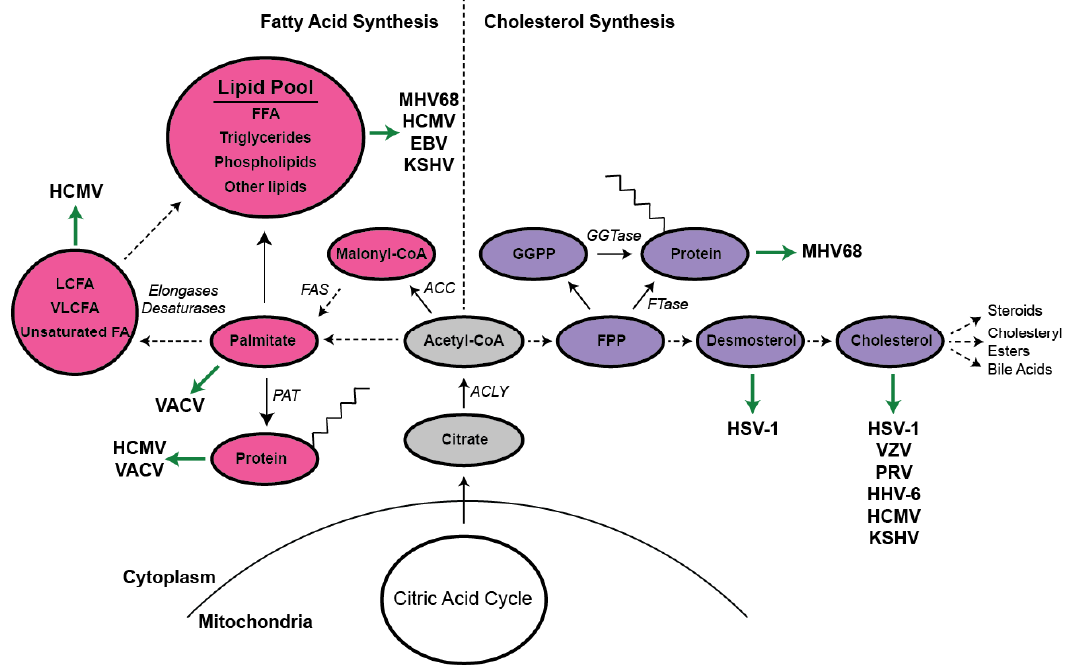
Figure 1. Summary of the interplay between DNA virus infection and cellular lipid metabolism. This model illustrates a number of enzymes and intermediates involved in the synthesis of cholesterol (purple, right side), fatty acids (pink, left side), and related compounds. The precursor acetyl-CoA feeds both the mevalonate and fatty acid synthesis pathways. Virus interactions with these compounds are indicated by green arrows. Solid black arrows indicate the direct conversion of one molecule to the next, whereas dashed arrows indicate additional steps that, for the sake of simplicity, are not depicted. To conserve space, prenyl and palmitoyl moieties are depicted with only eight carbons. MHV68 (murine herpesvirus 68), HCMV (human cytomegalovirus), EBV (Epstein–Barr virus), KSHV (Kaposi’s sarcoma herpesvirus), VACV (vaccinia virus), HSV1 (herpes simplex virus-